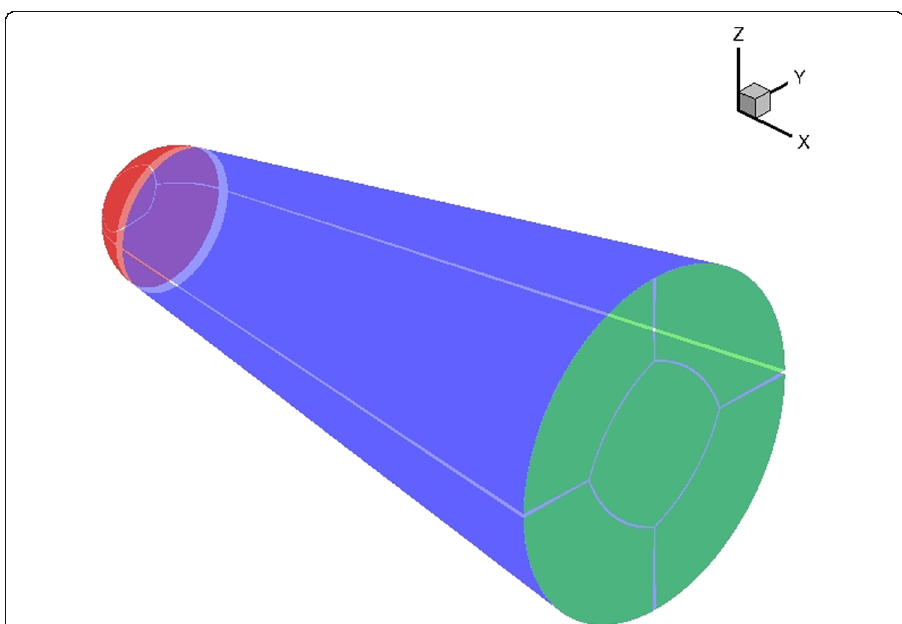
Fig. 12 The sketch diagram of components of the blunt cone, red-head, blue-body, green-bottom